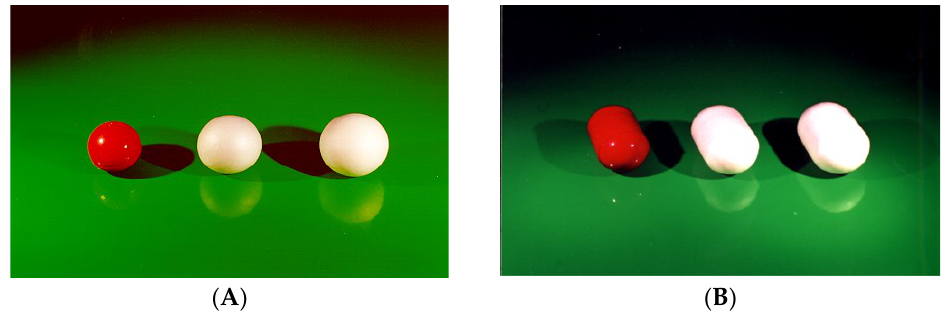
Figure 24. Chronotopic ® systems having soft-gelatin (format 2 round) ( A ) and hard-gelatin capsules (DBcaps, size B) ( B ) as the core.